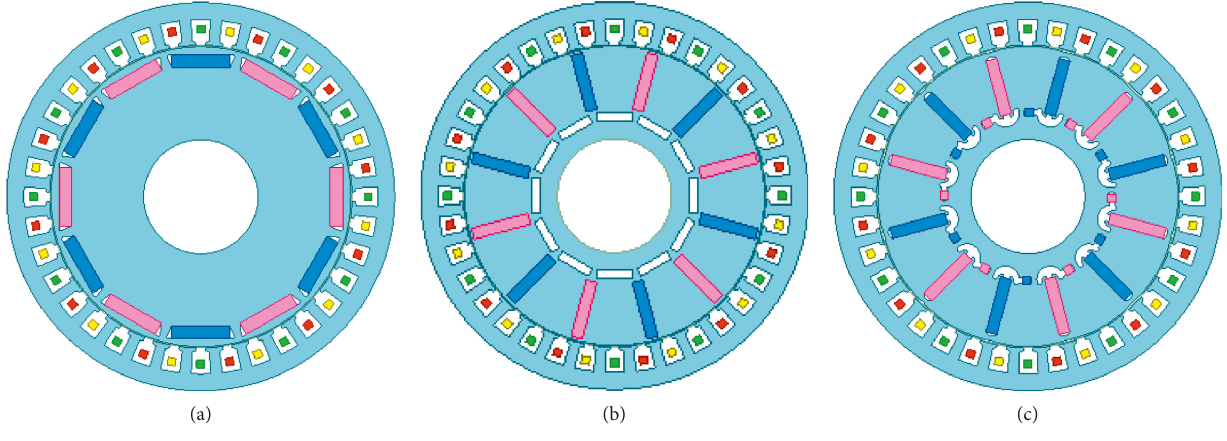
Figure 1: Structure of ITQPMG. (a) IRPMG. (b) ITPMG. (c) ITQPMG. Table 1: Initial design parameters of the generator.